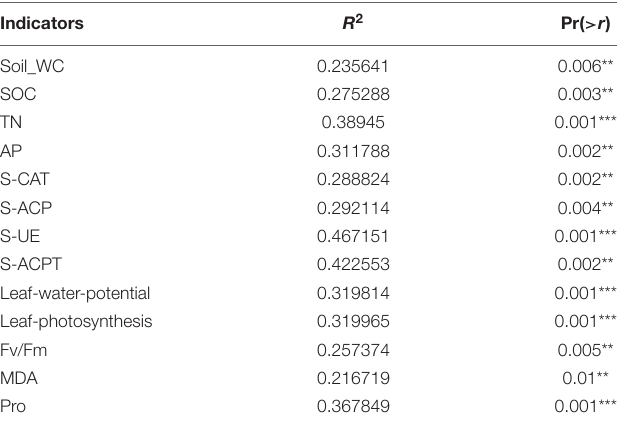
TABLE 3 | Correlation display of each factor and principal component of RDA